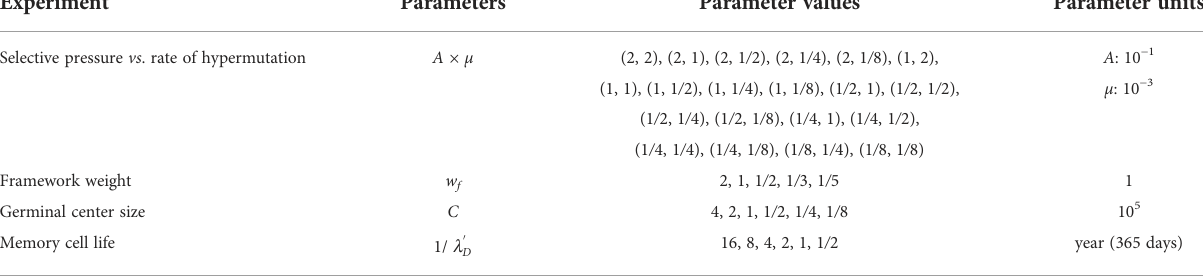
TABLE 3 Experiment